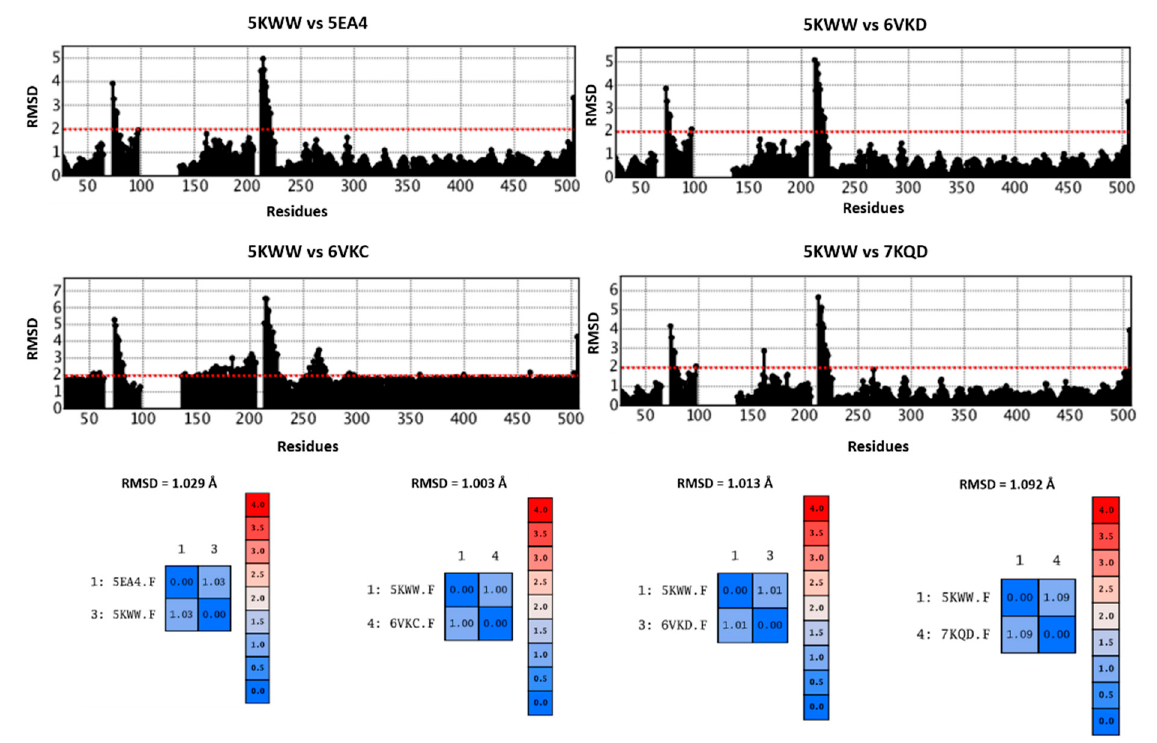
Figure 13. Comparison of 5KWW with the 5EA4, 6VKD, 6VKC, and 7KQD PDB codes. RMSD values based on CA evaluation are listed and plotted with respect to the protein